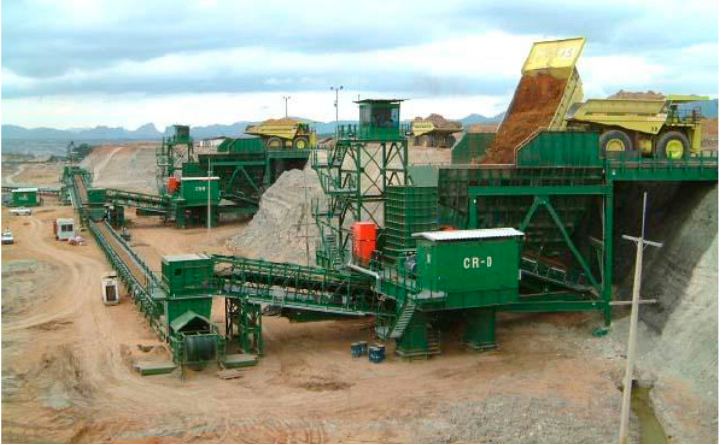
Figure 6. Semi-Mobile In-pit Crushing and Conveying systems (Source: Sandvik Mining and Construction).